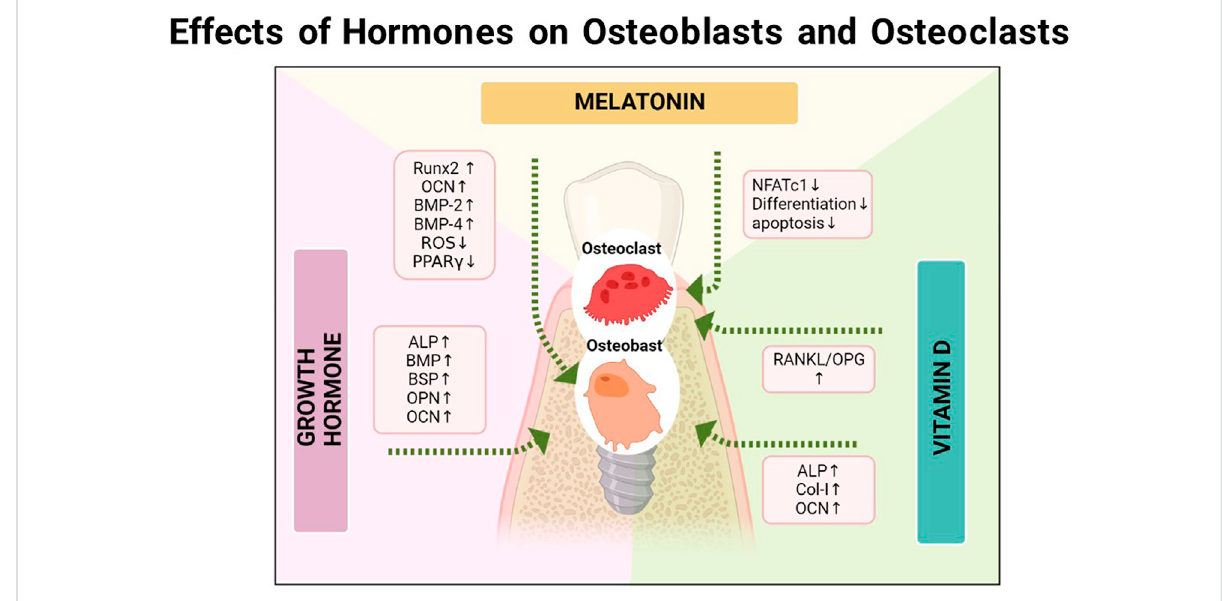
FIGURE 4 The relationship between the osseointegration and the vitamin D, melatonin, and growth hormone,